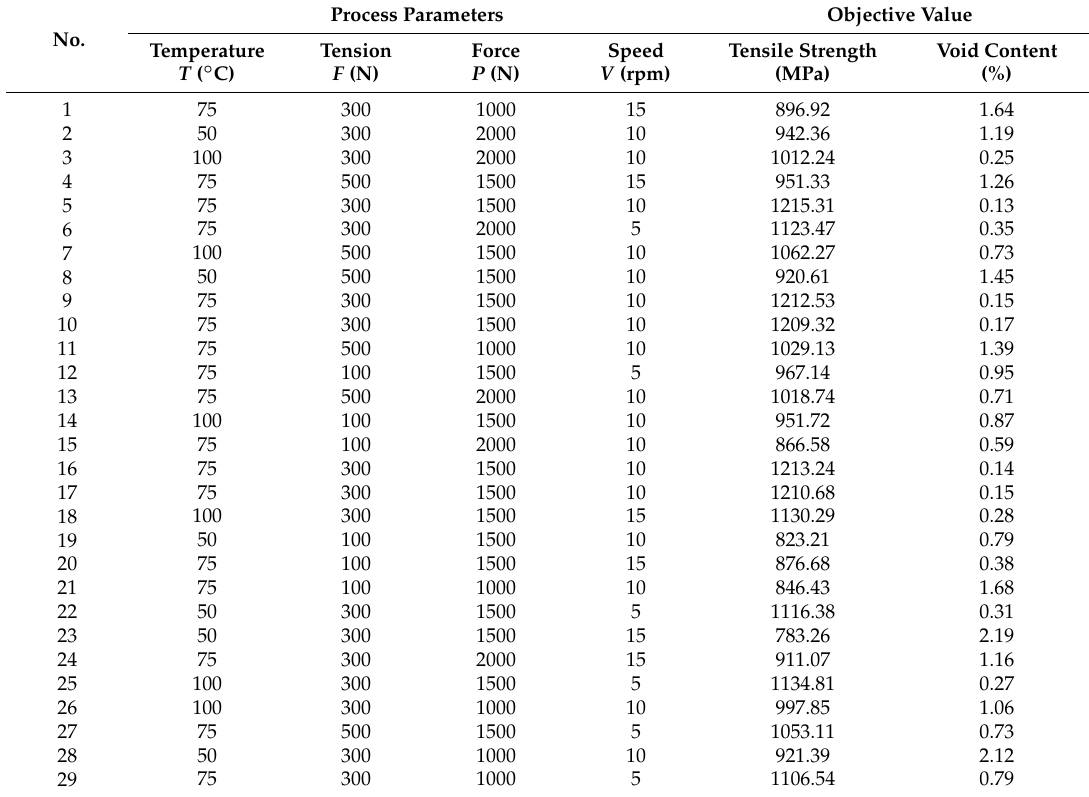
Table 1. Experiment and measurement results.